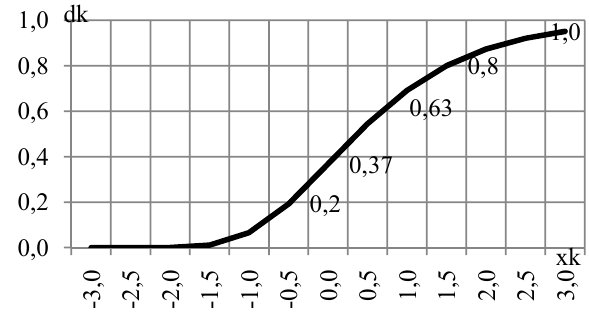
Fig. 1. Generalized Harrington function